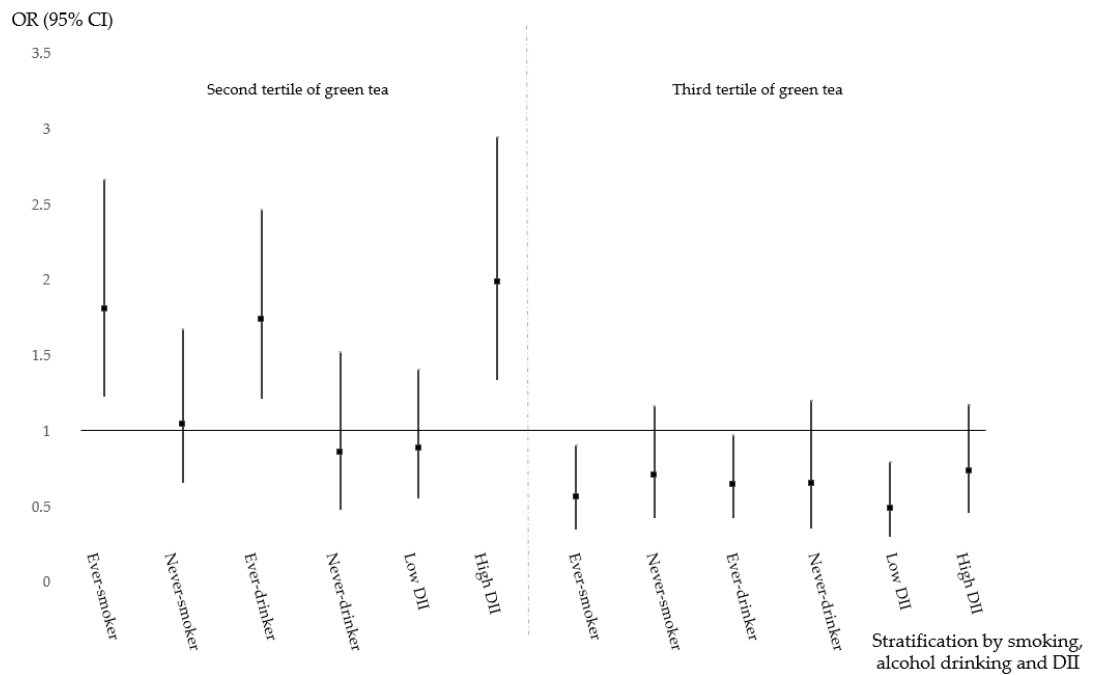
Figure 3. Green tea consumption and the risk of rectal cancer stratified by demographic characteristics.